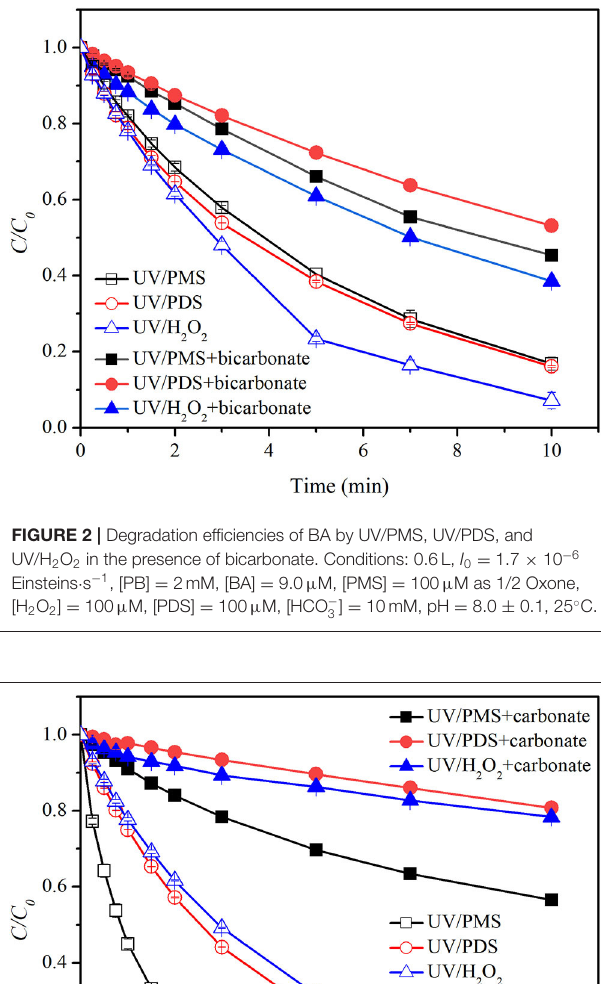
6) (Zhang et al., 2018). The values of k radical,BA / k radical,bicarboante